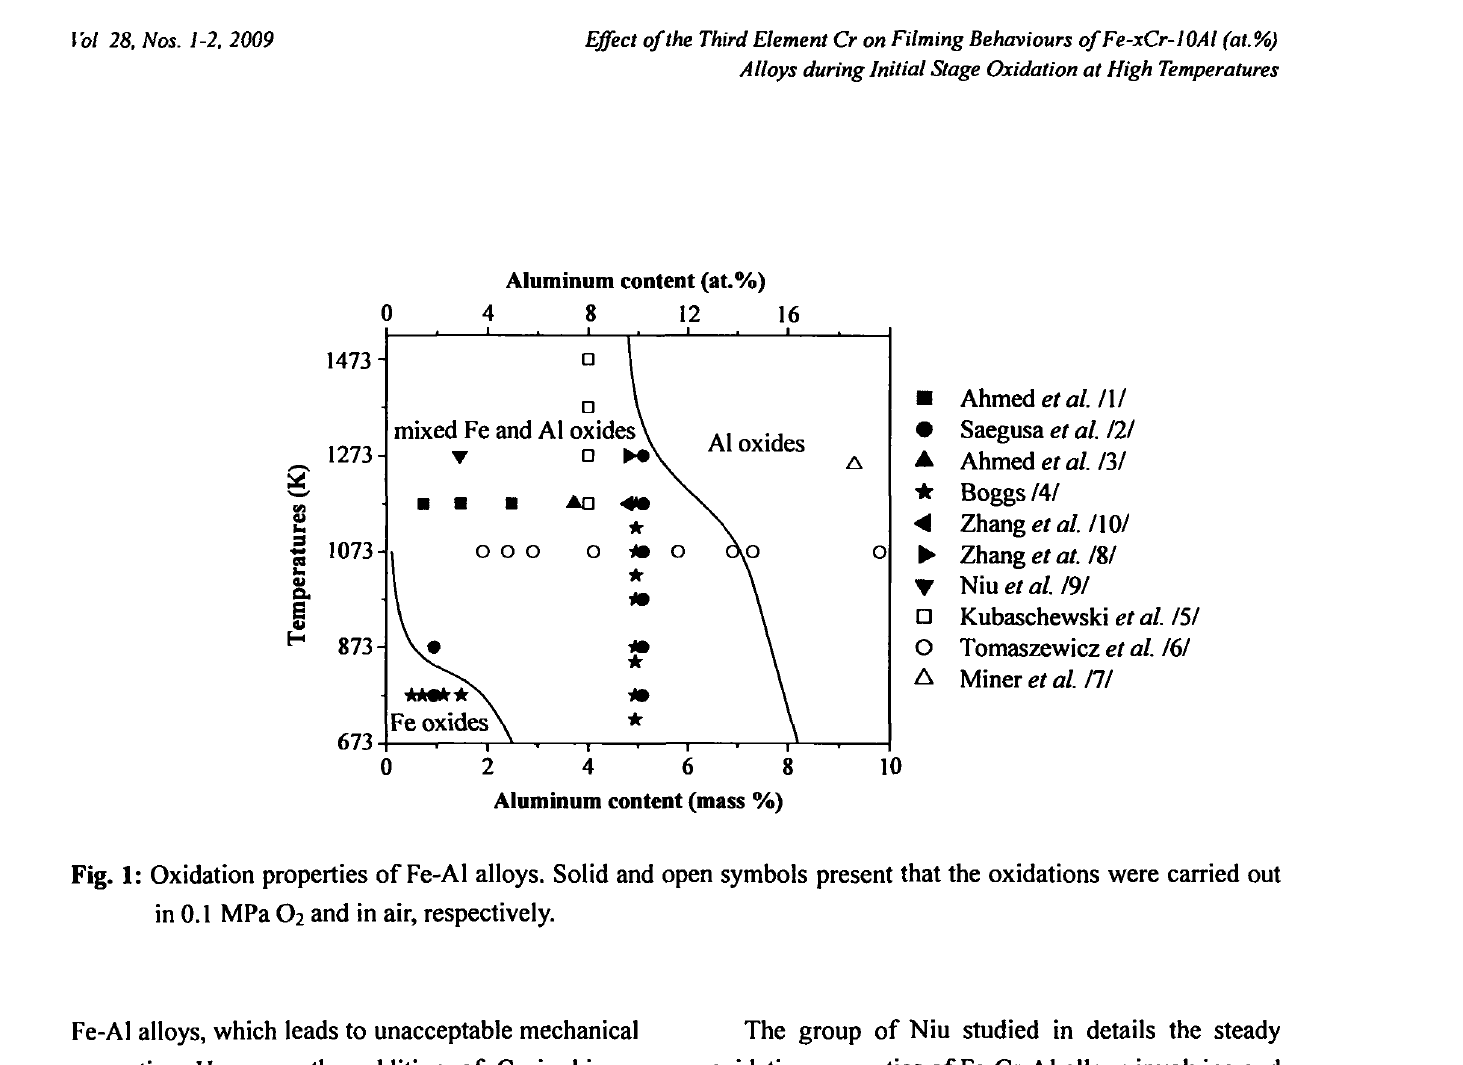
Fig. 1: Oxidation properties of Fe-Al alloys. Solid and open symbols present that the oxidations were carried out in 0.1 MPa Ο and in air, 2